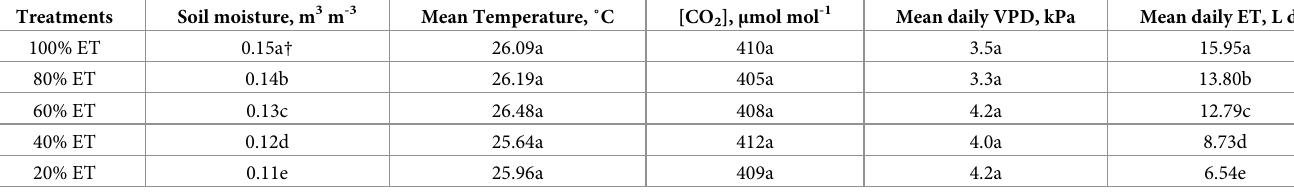
Table 1. Environmental variables during the experimental